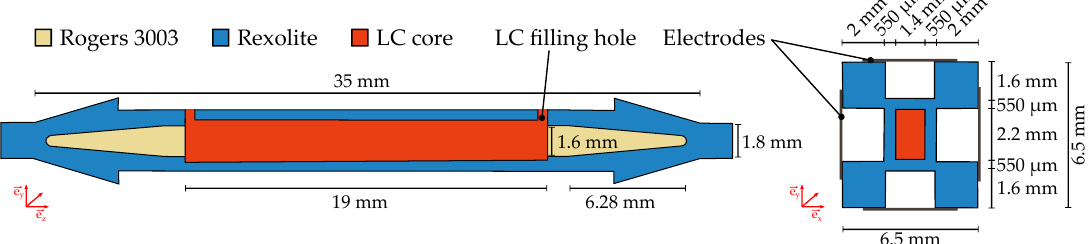
Figure 23. Cross section of the step-index fiber phase shifter with the LC cavity highlighted in red.